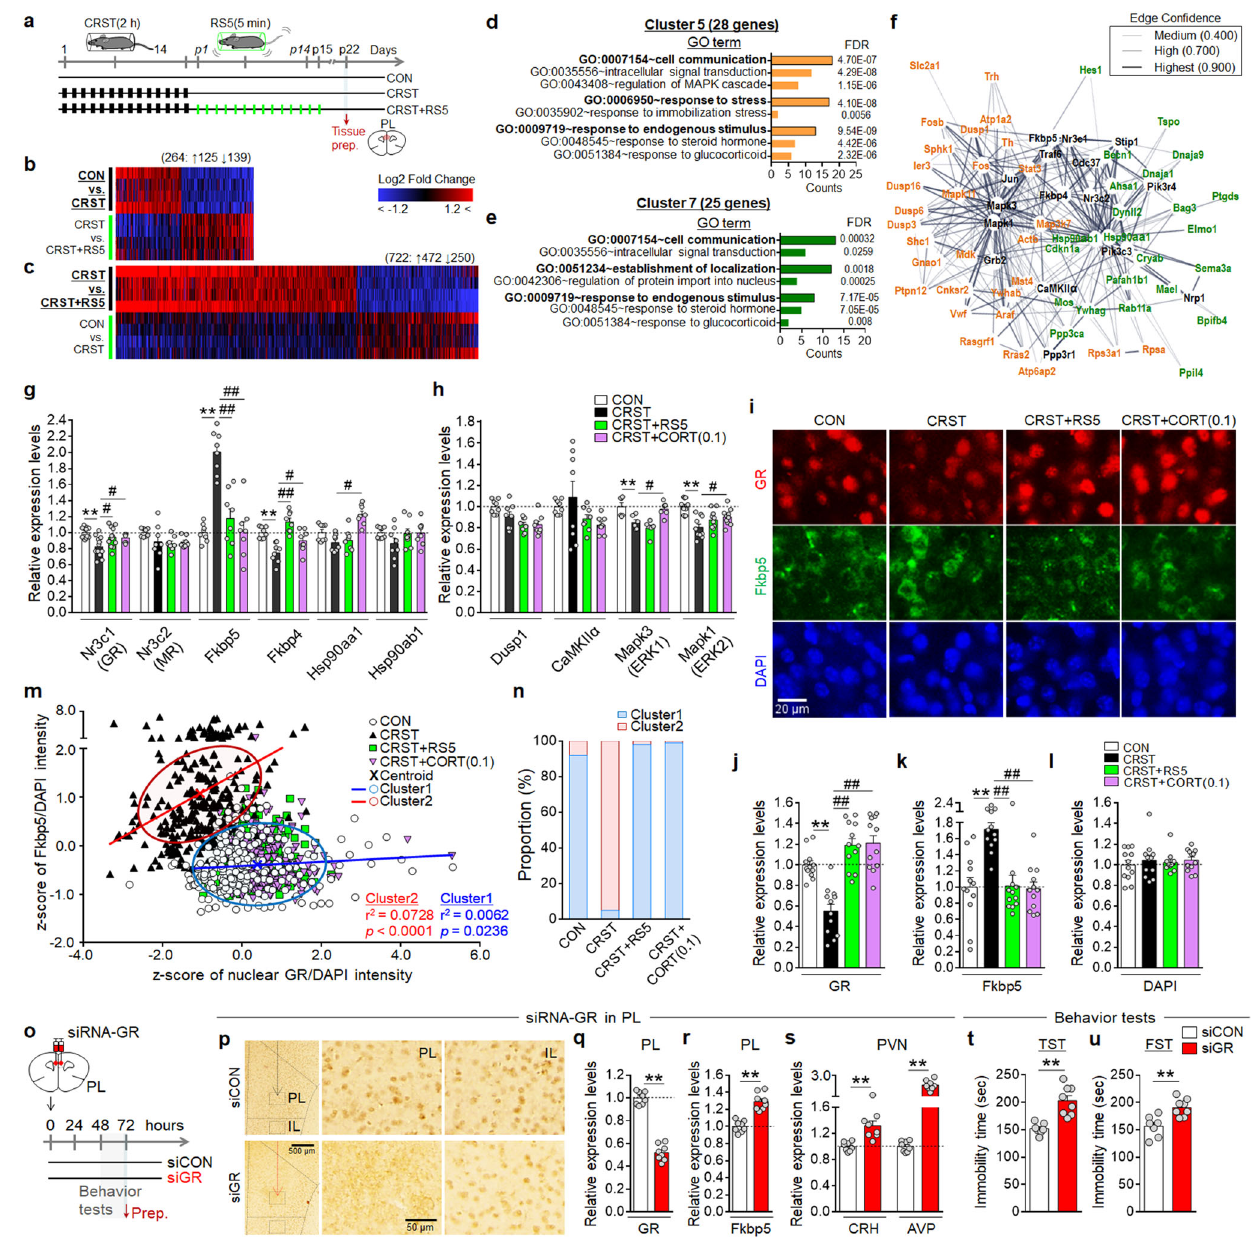
Fig. 5 RS5 treatment reverses stress-induced gene expression changes in the PL. a – c Experimental design ( a ). Heatmap showing the expression pro fi les of genes changed by ≥ 1.2-fold after CRST ( b ) and those changed by RS5 treatment in CRST mice ( c ), and follow-up unbiased alignment with expression levels of the respective genes changed by RS5 ( b ) and CRST ( c ), respectively. ↑ and ↓ , indicate up- and down-regulation, respectively. d – f Two clusters identi fi ed from GO enrichment analysis with weighted K -means clustering of gene expression pro fi les ( d , e ). The PPI networks formed by the genes of clusters 5 (orange, 28 genes) and 7 (green, 24 genes) and 16 genes (black) were identi fi ed from an extended search of the STRING database at a con fi dence level of >0.700 ( f ). g , h Transcript levels of GR(Nr3c1), MR(Nr3c2), Fkbp5, Fkbp4, Hsp90aa1, and Hsp90ab1 ( g ) and Dusp1, CaMKII α , ERK1(Mapk3), and ERK2(Mapk1) ( h ) in the PL of the indicated groups ( n = 8 – 12 per group). i – n Immuno fl uorescence images showing total GR (red) and Fkbp5 (green) expression in the PL for the indicated groups ( i ). DAPI, blue. Quanti fi cation levels of GR ( j ), Fkbp5 ( k ), and DAPI intensity ( l ) ( n = 4 – 6 animals per group). Two distinct clusters with differential expression of GR and Fkbp5 across individual cells for the indicated groups ( m ), and the % composition of individual cells of each group in the clusters ( n ) ( n = 248 – 309 cells from 4 – 6 animals per group). o – u Experimental design ( o ). Immunohistochemical images showing siRNA-mediated knockdown of GR expression ( p ) and GR transcript levels ( q ) in the PL. Transcript levels of Fkbp5 in the PL ( r ), and of CRH and AVP in the PVN ( s ) of mice injected with siRNA-GR in the PL. Immobility time in the TST ( t ) and FST ( u ) for the indicated groups ( n = 6 – 8 per group). Data were mean ± SEM. *, the difference compared to control; #, the difference compared to CRST. *, #, p < 0.05; **, ##, p < 0.01 (Two-sided Student ’ s t -test; one-way ANOVA followed by Newman – Keuls post hoc test). See Supplementary Data 4 for statistical details.